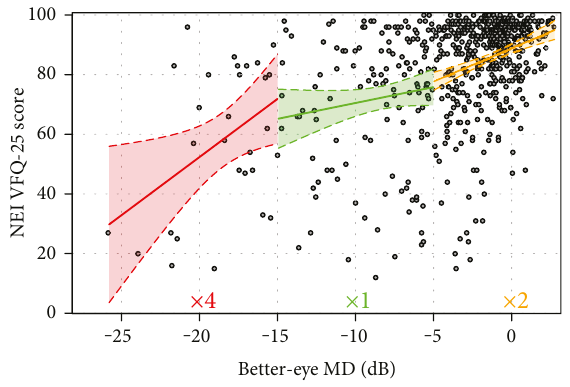
Figure 2: Fitting of three OLSR lines with 95% con fi dence limits for each phase of decline in VRQL. Points represent scores on the NEI VFQ-25 and BEMD in 636 patients. The green phase shows the slowest decline in NEI VFQ-25 score; the yellow line shows quicker decline where NEI VFQ-25 scores reduce 2 times faster than that in the green phase. The red line shows decline on NEI VFQ-25 as about four times quicker than that in the green phase.